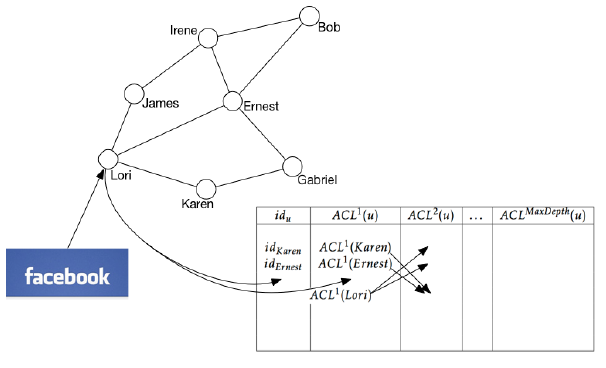
Figure 4. Example of the propagation procedure - phase 3 The procedure, then, continues in propagating users information in deeper levels until no futher computation is possible, that is, when the ACL 1 (Lori) has been propagated to each of Lori’s contacts and their ACL s have been propagated too (see Figure 5). As such, by exploiting the presented collaborative graph reconstruction, the framework is able to compute ACL n , where n ≥ 2, obtaining a social graph representation much wider than the one represented by only ACL 1 .